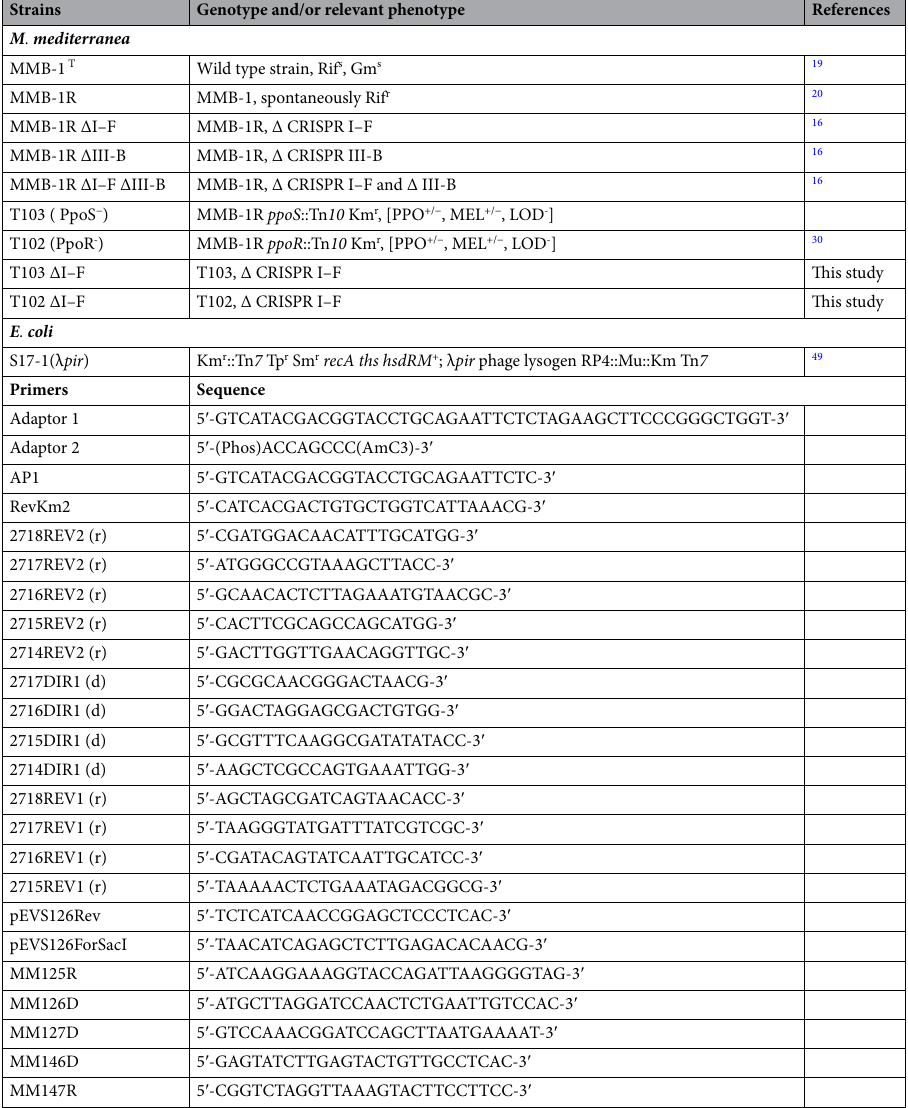
Table 1. Strains, plasmids and primers used in this study. The phenotypes described for the strains inside the brackets mean: PPO +/− (decrease of all PPO activities), MEL +/− (decrease of melanin synthesis), LOD- (loss of lysine oxidase activity). Primers are marked with (d) meaning direct if they hybridize with the template strand, or (r) from reverse if they hybridize with the coding